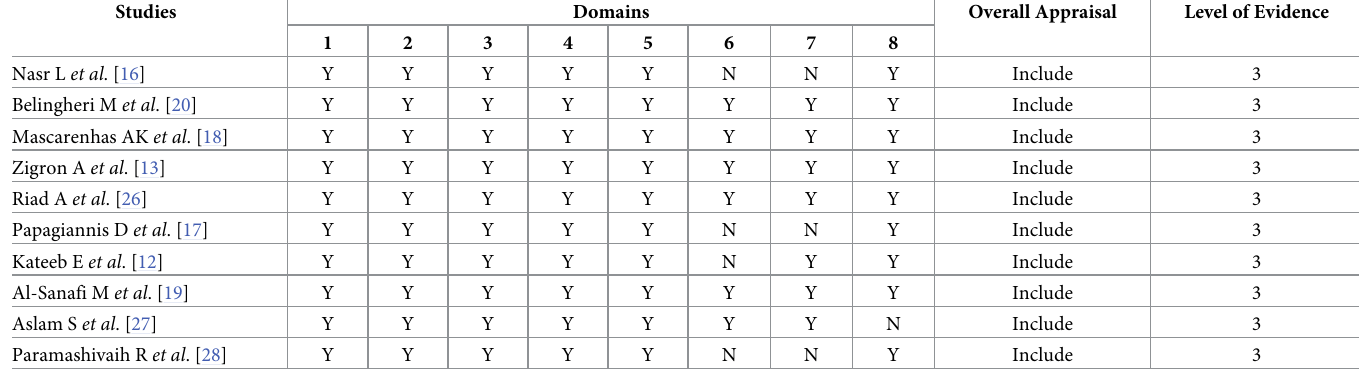
Table 2. Risk of bias assessment using the Joanna Briggs Institute (JBI) critical appraisal tool for analytical cross-sectional studies and the level of evidence of each included study. Studies